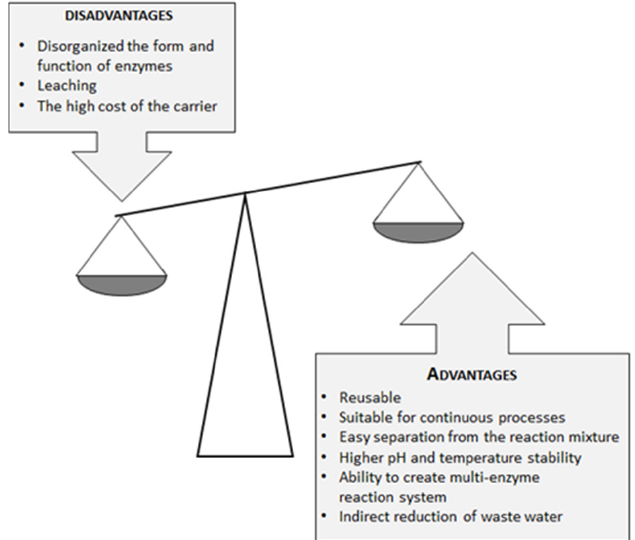
Figure 1. Advantages and disadvantages of heterogeneous biocatalysts (modified according to Ref. [45], with permission from publisher Josip Juraj Strossmayer of Osijek, Faculty of Food Technology Osijek, 2019).